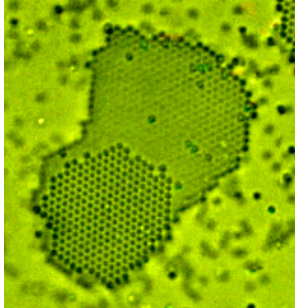
Figure 1. An obtained colloidal crystal containing three layers of regular arrays of polystyrene particles. Individual particles are clearly resolved at the particle level. The focal plane in this picture is adjusted at the third layer.